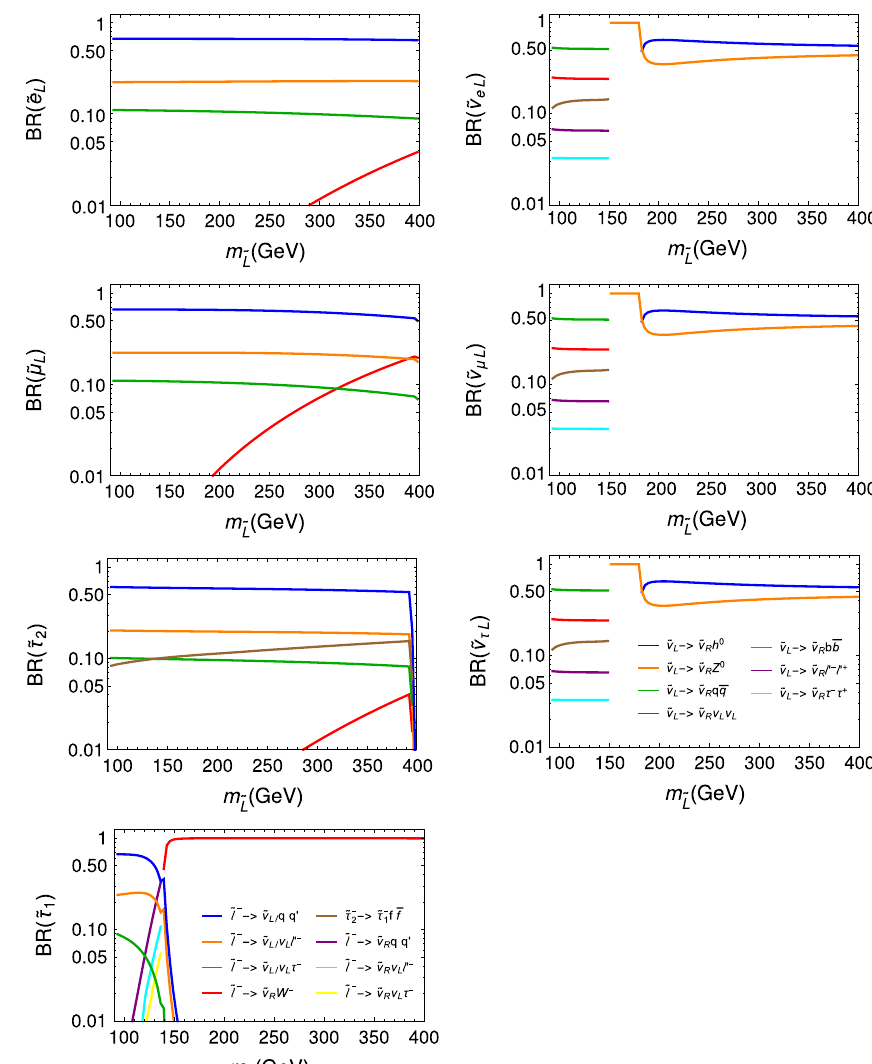
Fig. 3 Branching ratios for sleptons as a function of slepton soft mass m ˜ , for L < μ = 400 GeV. Decays for m ˜ L charged sleptons (sneutrinos) are shown on the left (right) column. The last panels describe the colors for the branching ratios shown in each